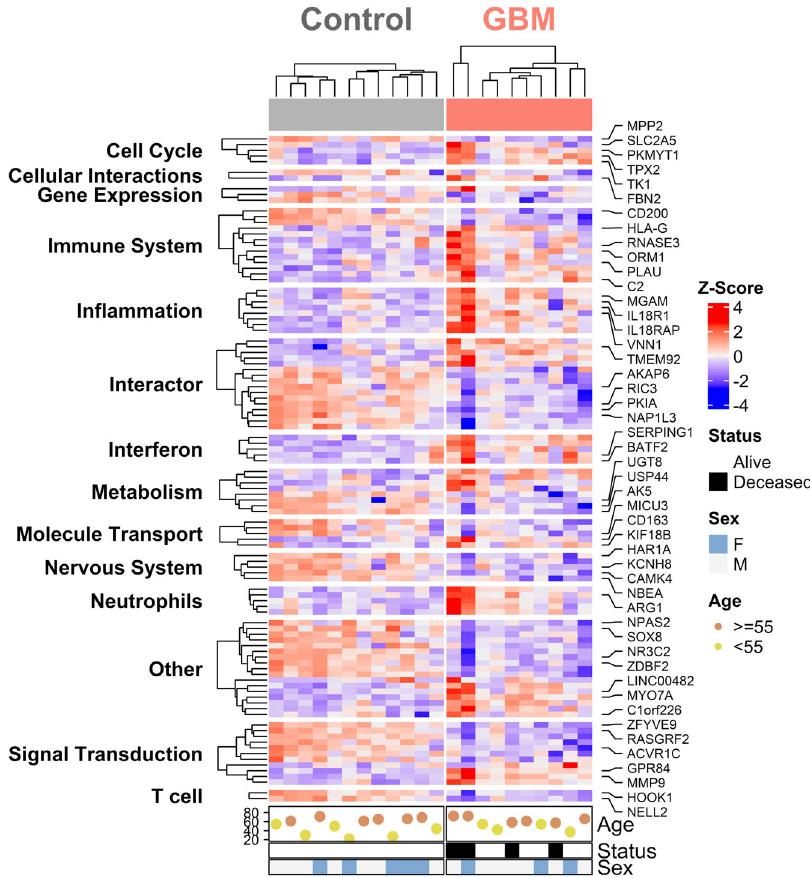
Fig. 4 GBM-associated DEGs. Heatmap of 105 narrow-downed DEGs in GBM blood samples from comprehensive analyses. Ages over 55 years are shown as brown dots. Hierarchical clustering was also applied. Genes were separated into blocks according to their potential functions or related pathways. C control, P GBM